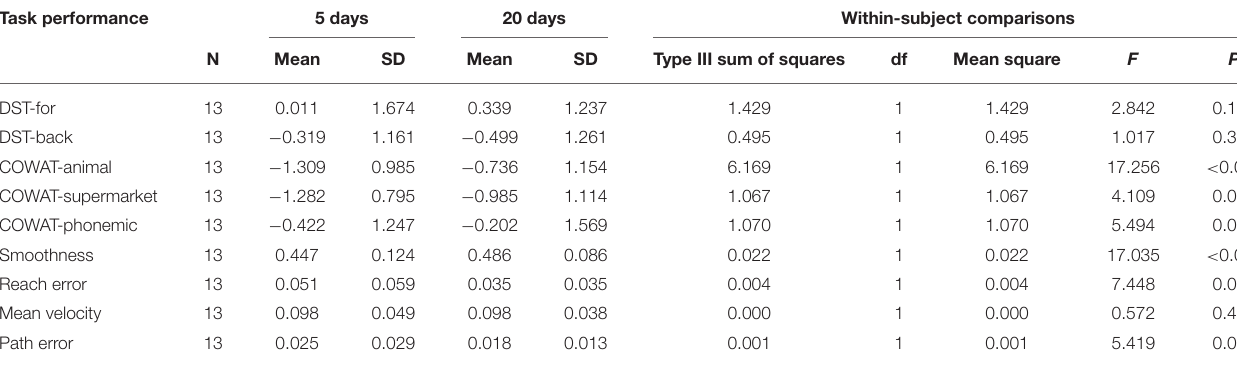
TABLE 1 | Single cognitive or motor task performance at day 5 and day 20 of robotic rehabilitation of the upper limb. Task performance 5